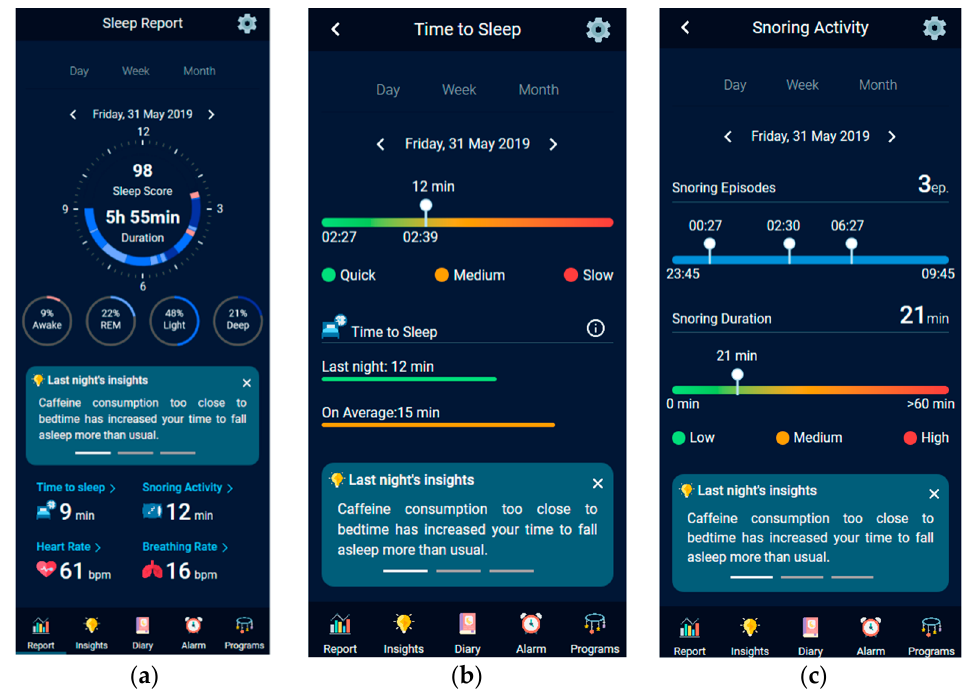
Figure 13. ( a ) Dashboard, ( b ) Time to Sleep, and ( c ) Snoring Activity.